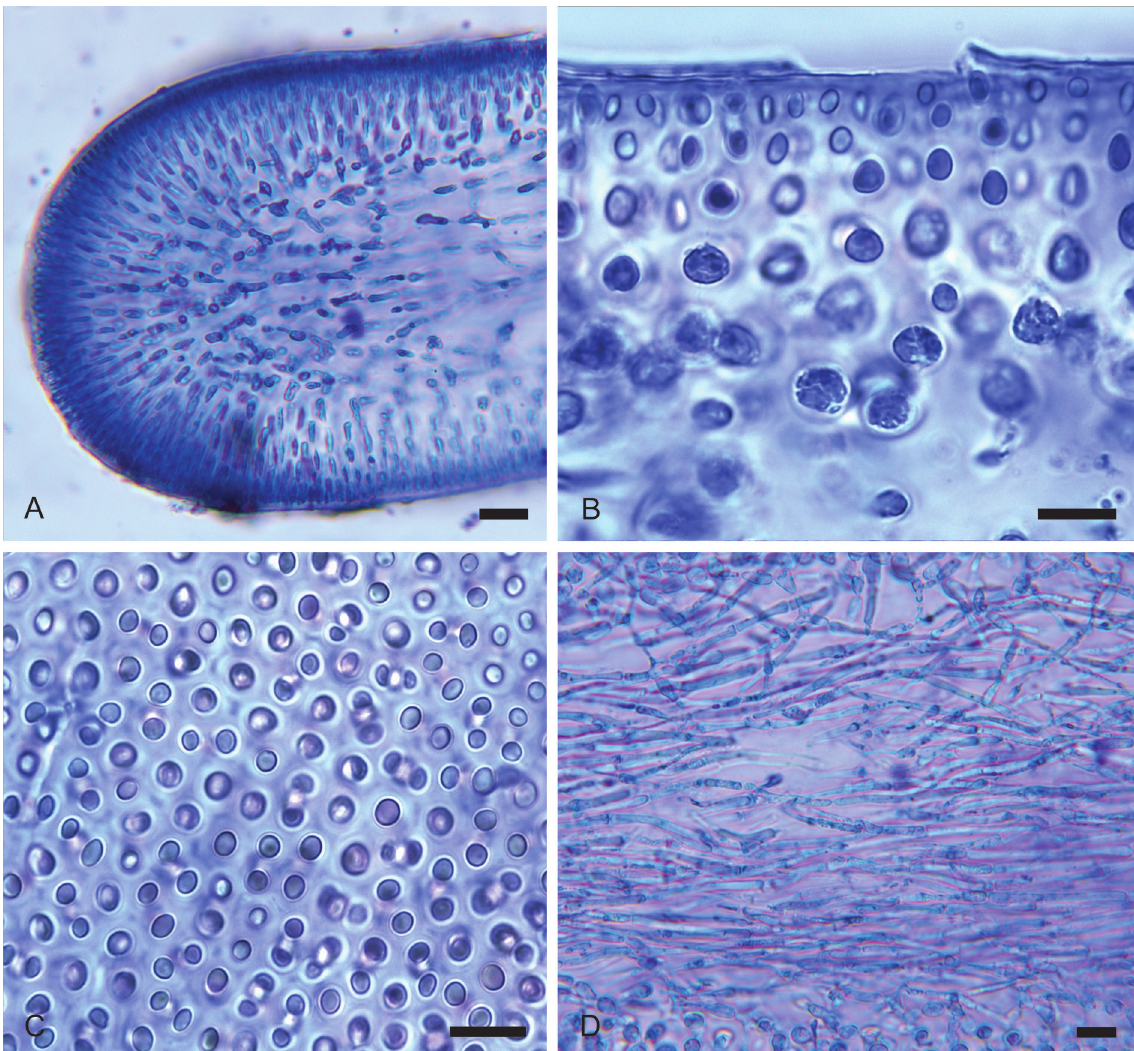
Fig. 2. Analine-blue stained vegetative features. A . A transapical longitudinal section indicative of its multiaxial structure. B . The anticlinal orientation of pseudo-dichotomous cortical filaments. C . Mostly paired cortical cells in surface view. D . Longitudinally aligned, peripherally inverwoven medullary filaments. Scale bars: A, D = 20 μm; B – C = 10